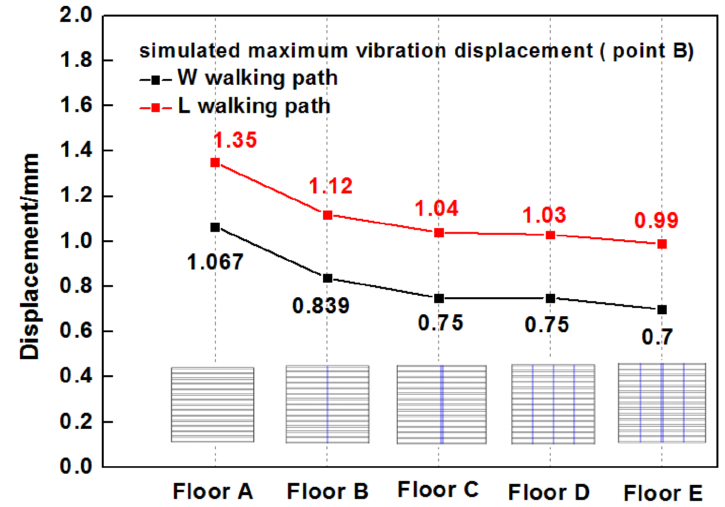
Figure 28. Simulated peak displacement at points B for different